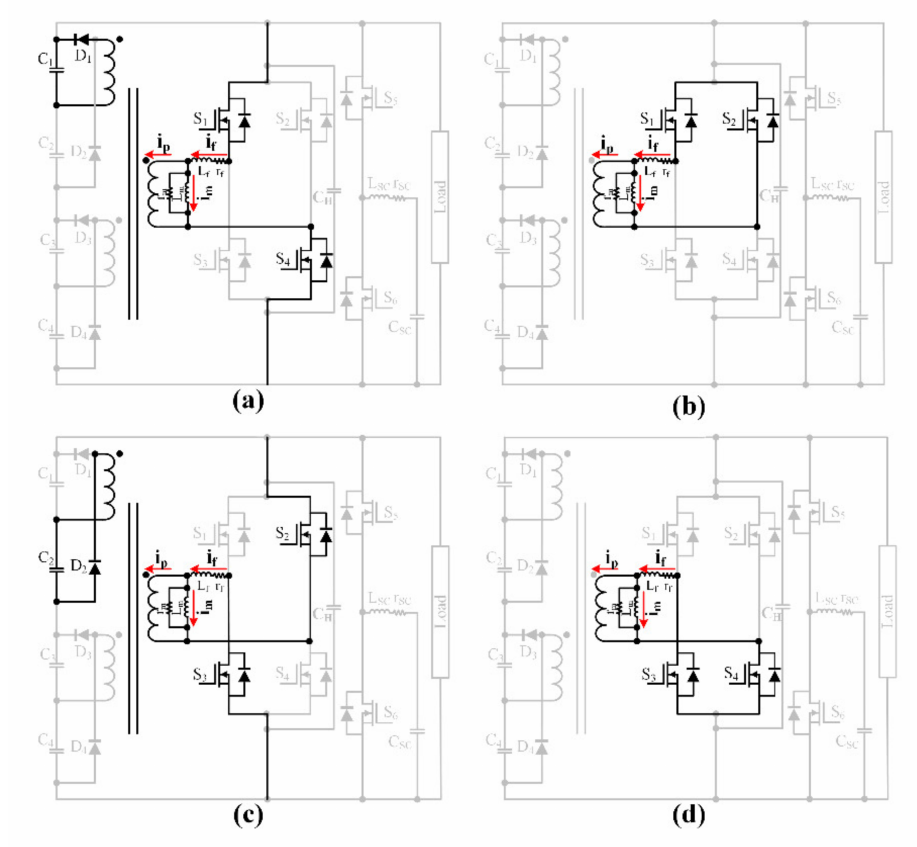
Figure 5. Di ff erent operation modes of the proposed equalizer. ( a ) Mode 1: t 0 < t < t 1 . ( b ) Mode 2: t 1 < t < t 2 . ( c ) Mode 3: t 2 < t < t 3 . ( d ) Mode 4: t 3 < t < t 4